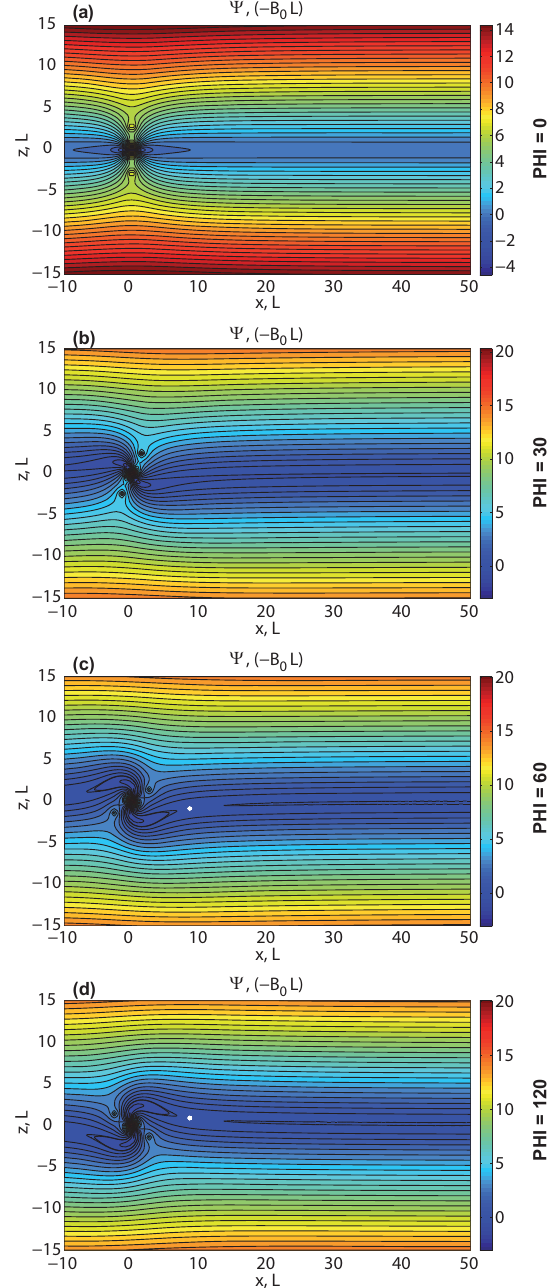
Figure 1. Magnetic potential (cid:57)(x,z) , calculated from the asymmet- ric Kan model (Eqs. 7–9) with parameters a = 0 and b 0 = 8. Solu- tions with dipole tilt angles PHI = { 0 ◦ , 30 ◦ , 60 ◦ , 120 ◦ } clockwise are plotted on panels (a) – (d) , respectively. PHI = − ϕ/ 2 of the ana- lytical model. Spatial units are normalized for typical CS width L . Magnetic potential is normalized for ( − B 0 L) . X points are marked